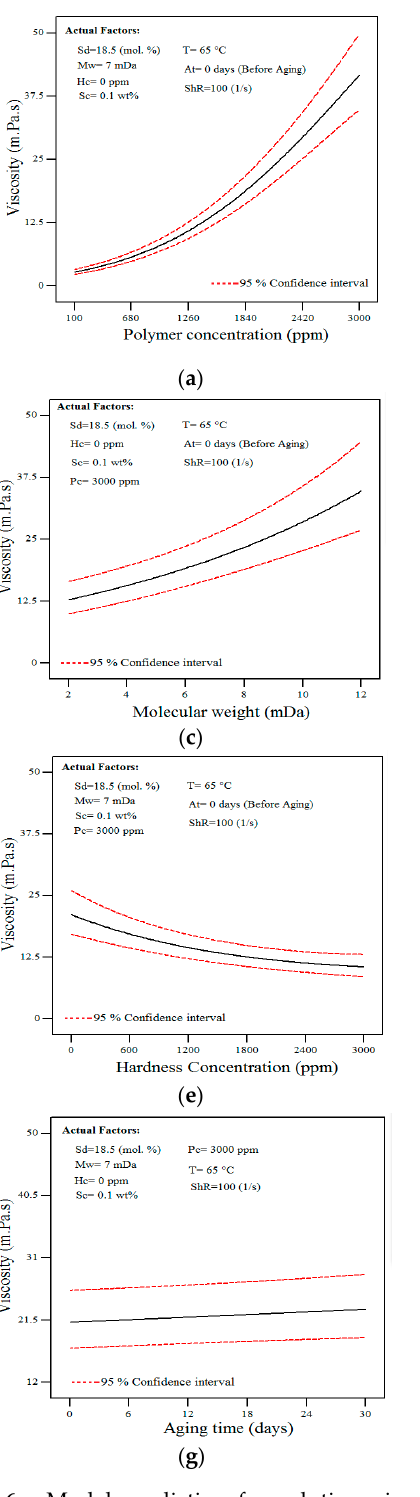
Figure 6. Model prediction for solution viscosity as a function of ( a ) polymer concentration, ( b ) sulfonation degree, ( c ) molecular weight, ( d ) salinity concentration, ( e ) hardness concentration, ( f ) temperature, ( g ) aging time and ( h ) shear rate.